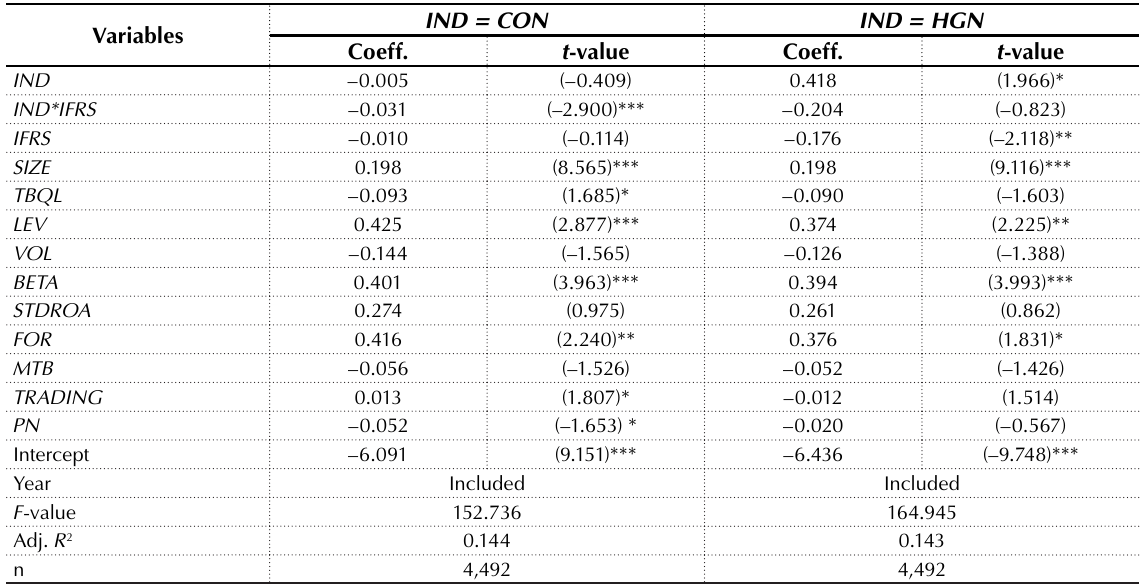
Table 4. Additional test for Hypothesis 1: sample excluding IFRS adoption year